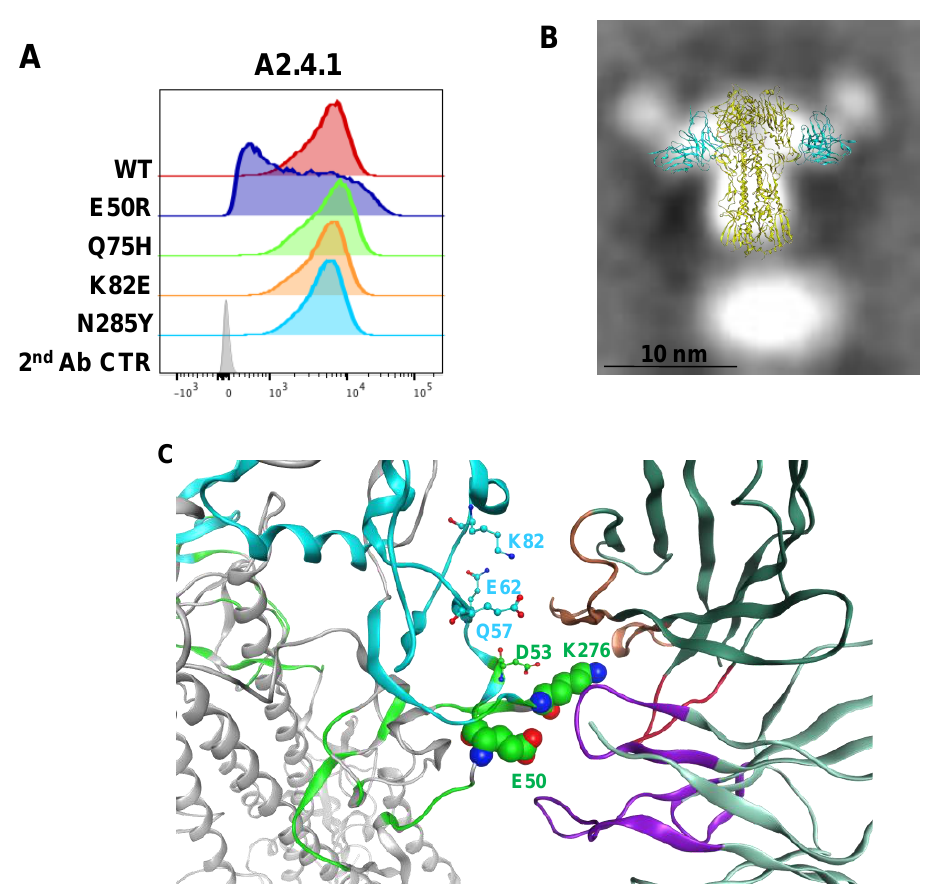
Figure 6. FACS analysis of point mutations in HA and modeling the A2.4.1 epitope. ( A ) Mutations made in AHK14 HA were evaluated by Sf9 expression and FACS dual staining with stem antibody CR8020 for gating of HA expression and A2.4.1 labeling for binding analysis as described in Figure 5. ( B ) The antibody angle of approach as visualized by TEM 2D class averaging images was used to screen the models of A2.4.1 Fv binding to the VE subdomain of AHK14 HA NP. ( C ) Protein–protein docking model of A2.4.1 binding used all six CDRs (LC CDRs, purple; HC CDRs 1&2 orange; HC CDR3, red). A2.4.1 binds antigenic site C (green) at K276, E50, and D53. VE subdomain (cyan) amino acids D53, Q57, E62, and K82 were also involved in docking.